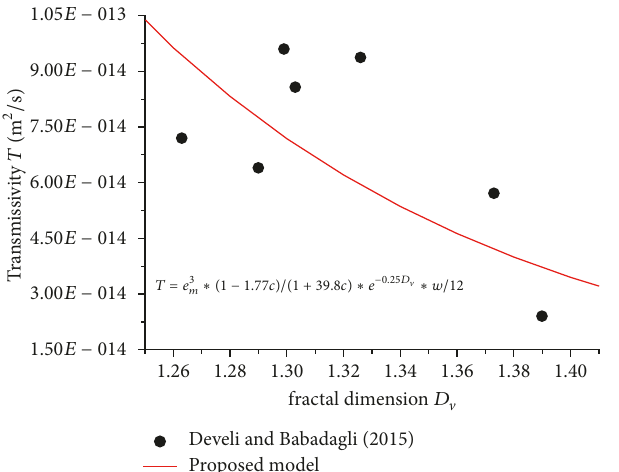
Figure 17: Validation of proposed model with flow experiment dada performed by Develi and Babadagli